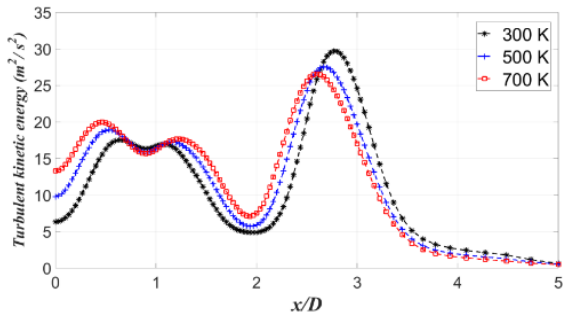
Figure 22. Turbulent kinetic energy distributions at varied inlet temperatures (z/D = 5).